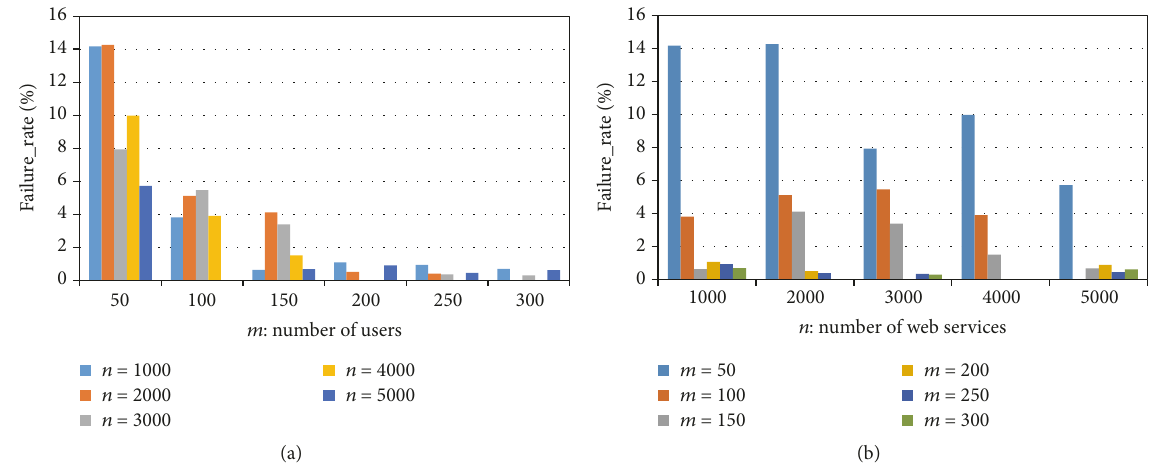
Figure 6: Recommendation failure rate of SerRec